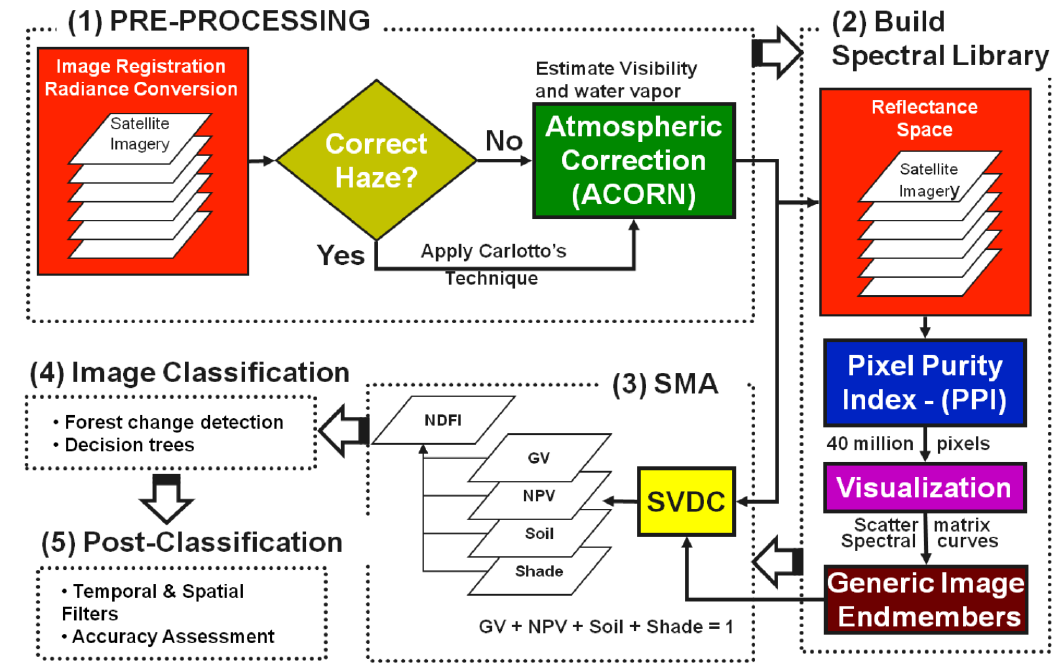
Figure 3. Basic image processing steps in ImgTools (taken from [56] with